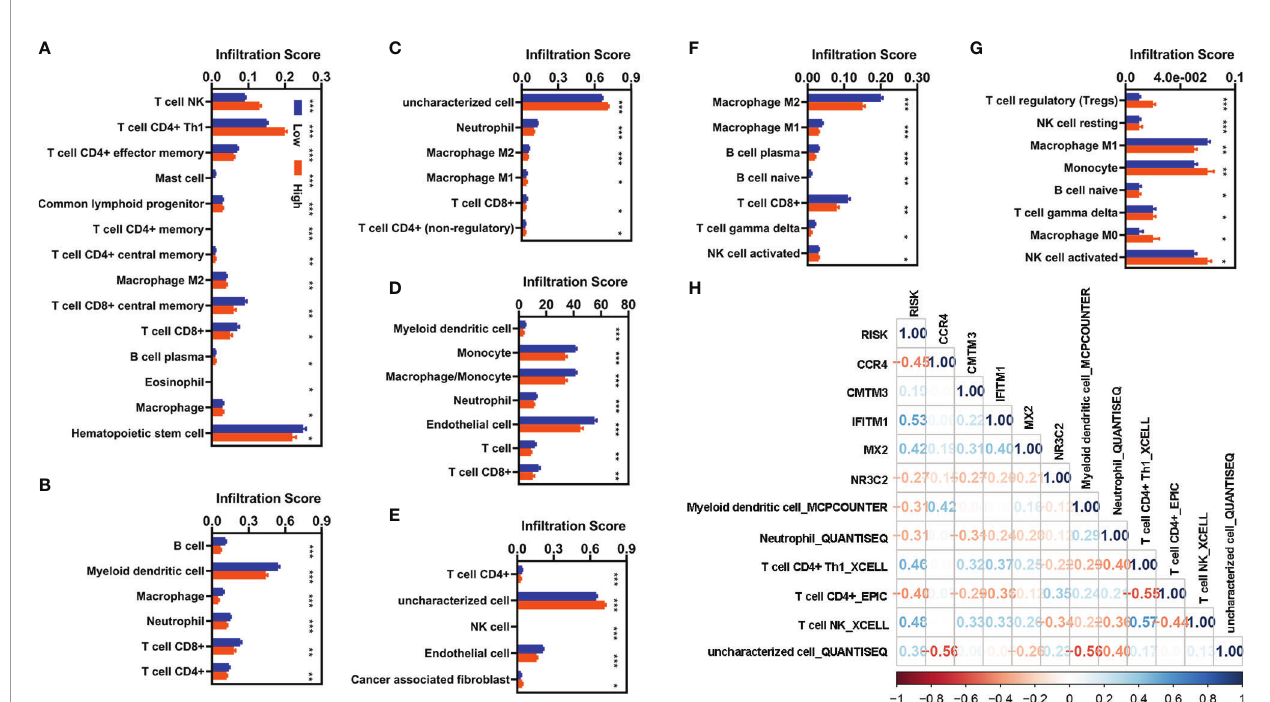
FIGURE 6 | Correlation analyses with the in fi ltration of immune cells and factors. (A – G) Differentially expressed analyses for in fi ltration of immune cells and factors with different risk value. (A) XCELL. (B) TIMER. (C) QUANTISEQ. (D) MCPCOUNTER. (E) EPIC. (F) CIBERSORT-ABS. (G) CIBERSORT. (H) Correlation analyses of these fi ve FI-DEGs and risk value with the immune cells and factors in the entire cohort. N (low) = 336, N (high) = 194. *p < 0.05, **p < 0.01, ***p <